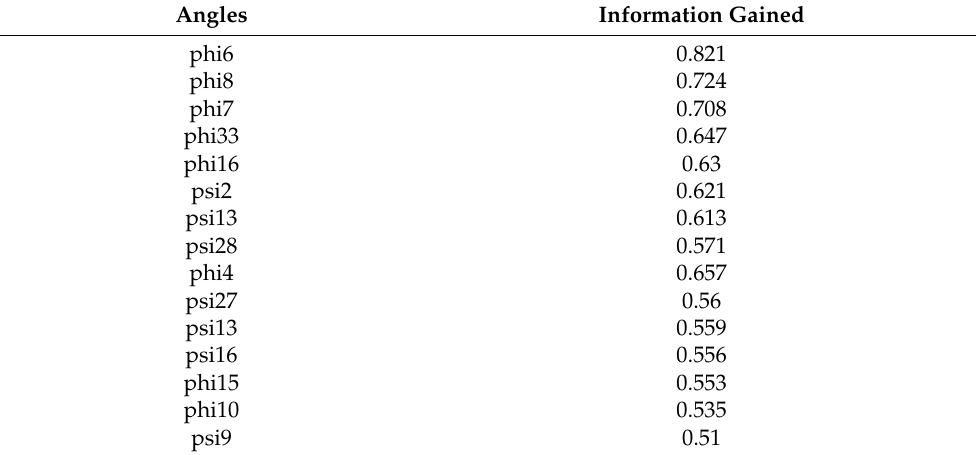
Table 3. Results of Ranking Data Set Capable of Sorting by Variant by